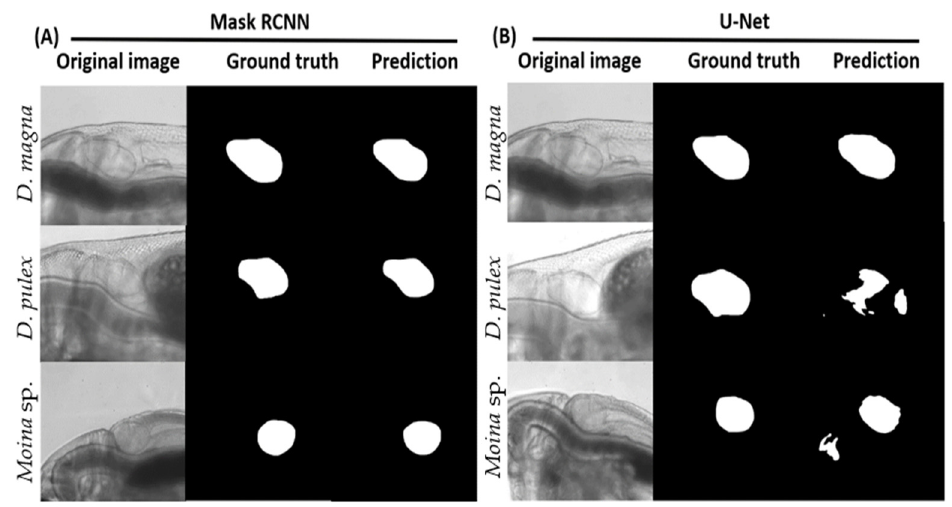
Figure 3. Image segmentation done using Mask RCNN ( A ) and U-Net ( B ) to predict heart size in water fleas. The white area show the predicted position of heart chamber. Three water flea species of D. magna , D. pulex, and Moina sp. were tested and the heart size for ground truth, and prediction is shown for comparison.